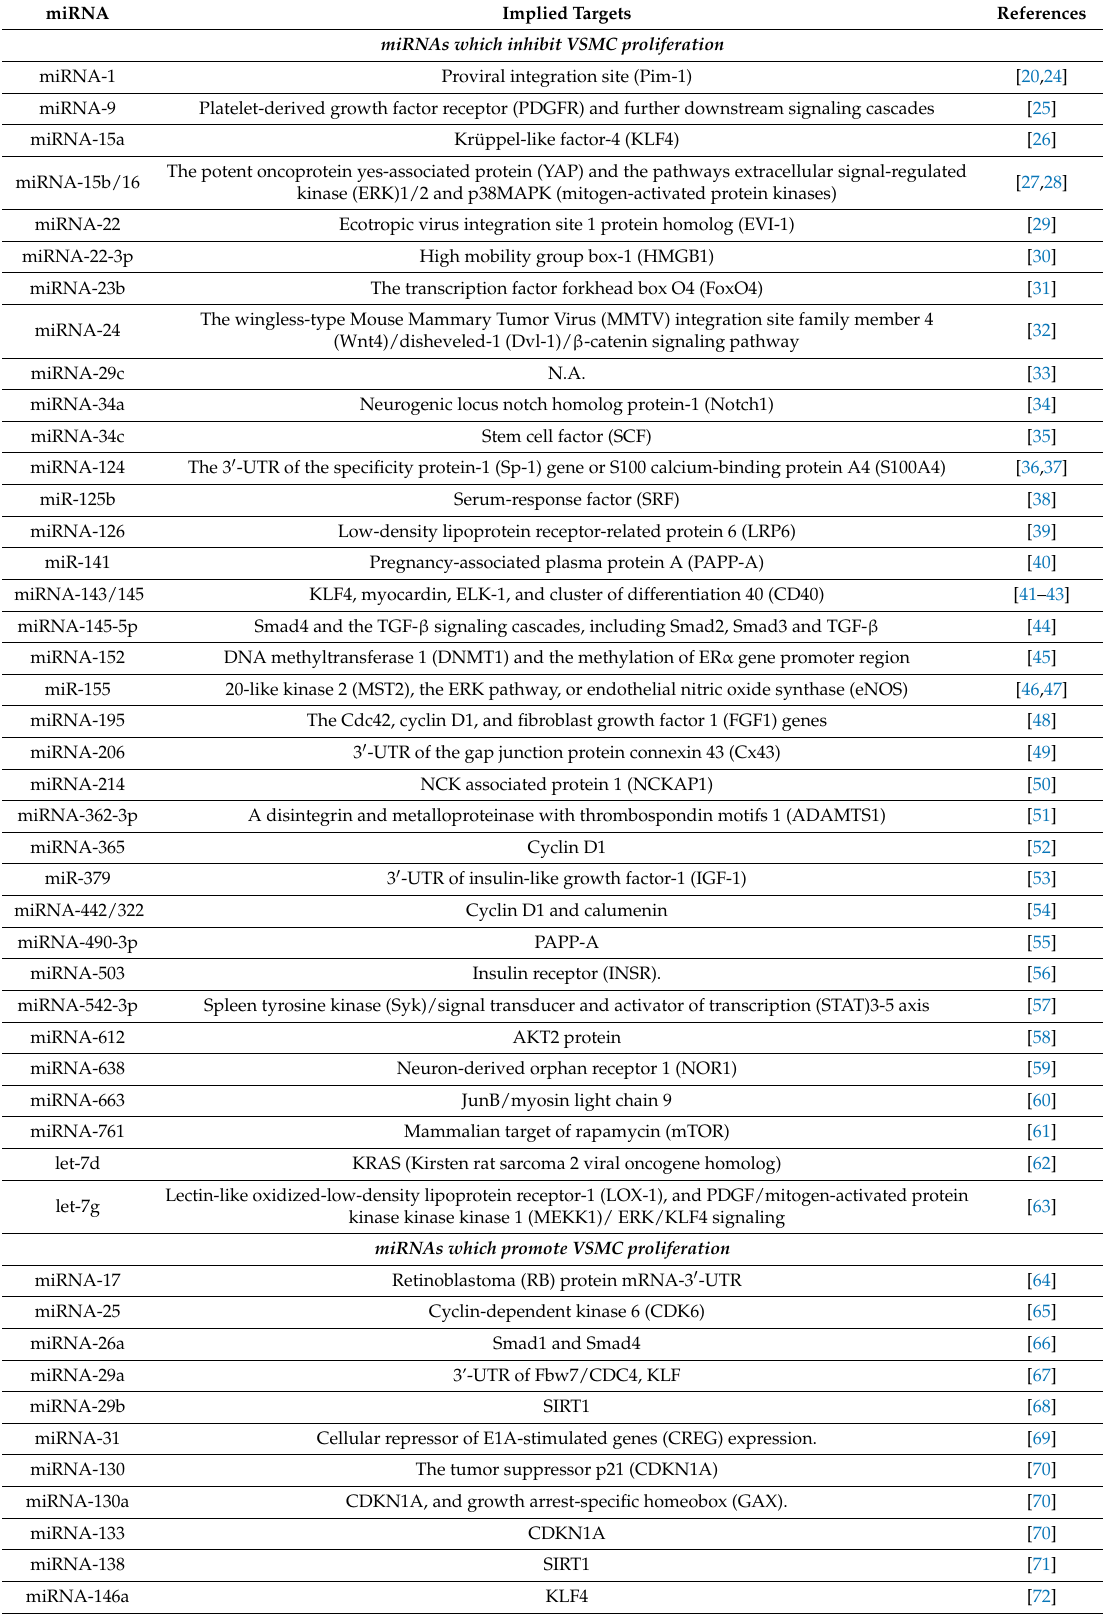
Table 1. miRNAs implied in the regulation of VSMC